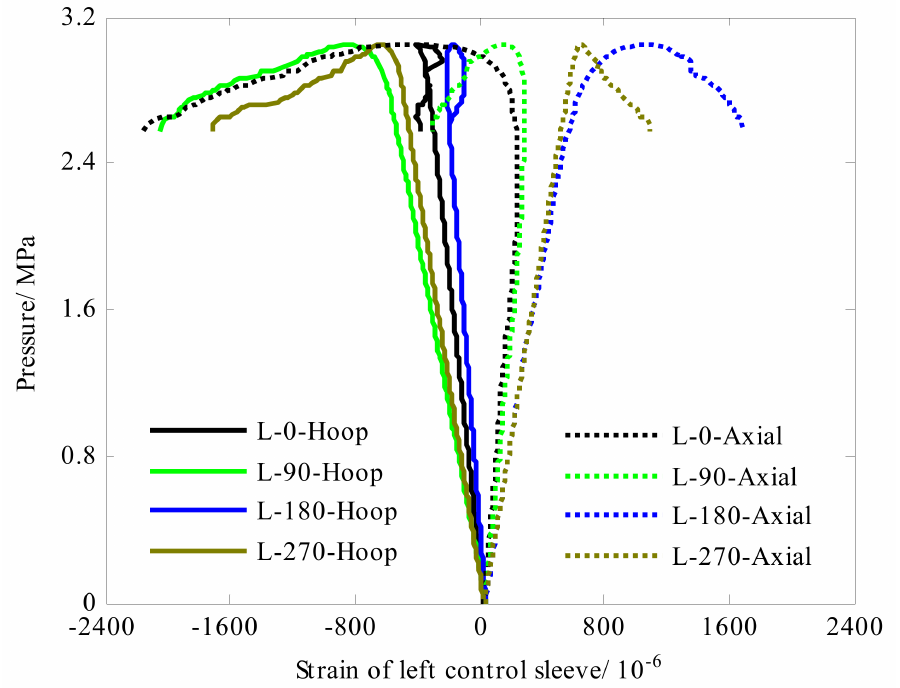
Figure 6. Strain response of the left control sleeve of cylinder A#.